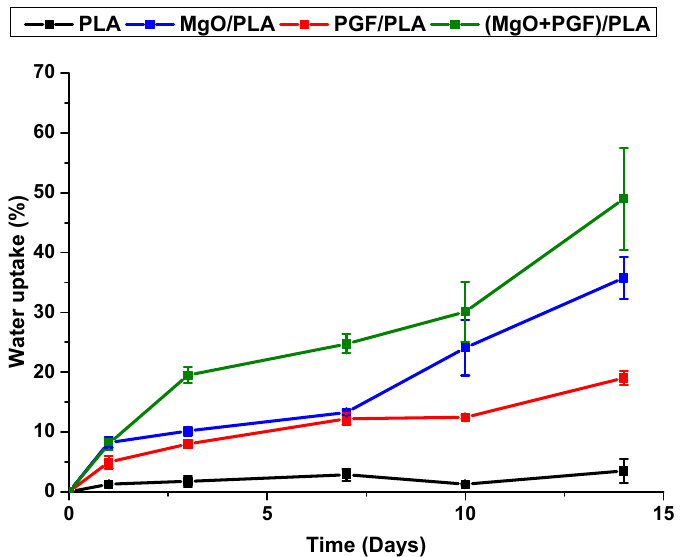
Figure 9. Water uptake profile of scaffolds during 14 days of in vitro degradation in Tris-HCl buffer under 37 °C.